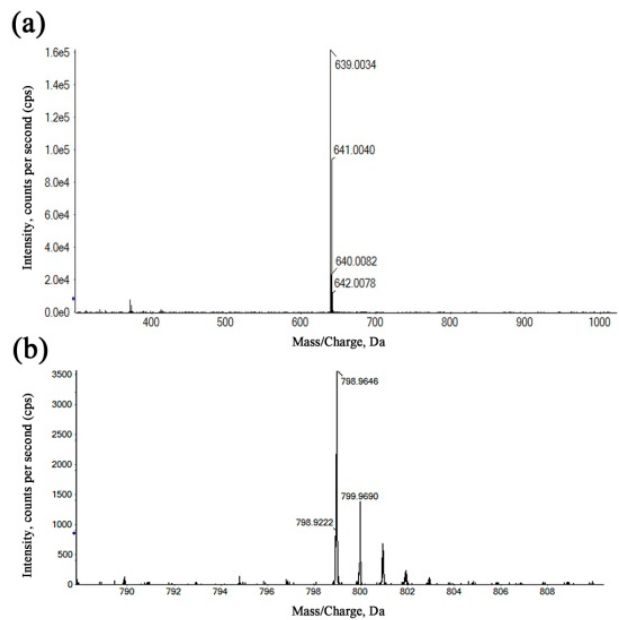
Figure 4. The high-resolution mass spectra (HRMS) of the kaempferol-gallium complexes. ( a ) 1:2 (metal-to-ligand ratio (M:L)) Kae-Ga, ( b ) 1:2 (M:L) Kae-SO 3 -Ga.